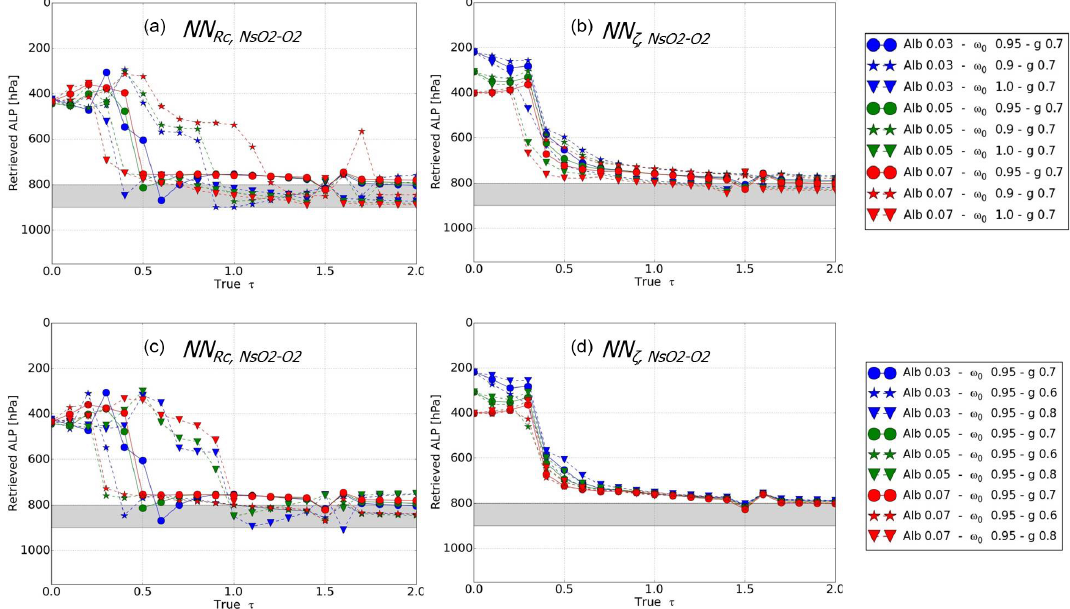
Figure 5. Simulated ALP retrievals, based on noise-free synthetic spectra with aerosols, as a function of true τ . All the retrievals are achieved with the two NN configurations (NN R and NN τ,N s ; see Sect. 3.1) trained with ω 0 = 0.95. The assumed geophysical conditions c ,N s O2 − O2 O2 − O2 are temperature, H 2 O, O 3 and NO 2 from climatology mid-latitude summer, θ 0 = 25 ◦ , θ = 25 ◦ and P s = 1010hPa. The reference aerosol scenario assumes fine scattering particles ( α = 1.5, ω 0 = 0.95, g = 0.7) located between 800 and 900hPa: (a, b) sensitivity of ALP retrievals to the aerosol single scattering albedo (true ω 0 = 0.95 or 0.9) in the synthetic spectra; (c, d) sensitivity of ALP retrievals to the aerosol asymmetry parameter (true g = 0.6, 0.7 or 0.8) in the synthetic